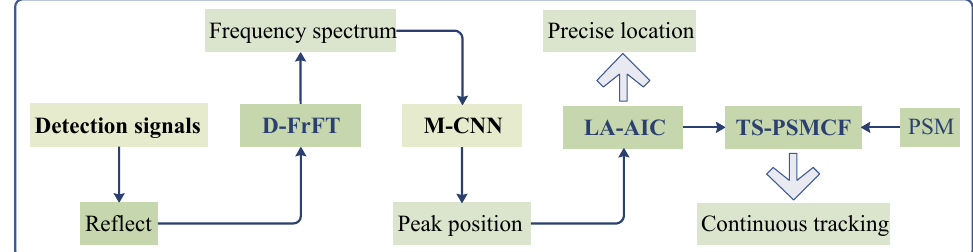
Figure 3. ST-BPN